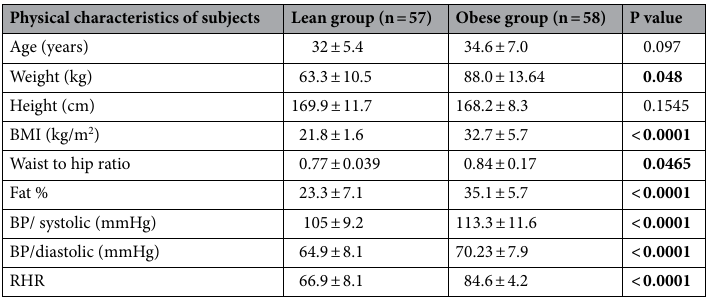
Table 1. Physical characteristics of the study population. Bold values denote statistical significance. All values are means ± standard deviations unless labeled otherwise. BMI body mass index, BP blood pressure, RHR resting heart